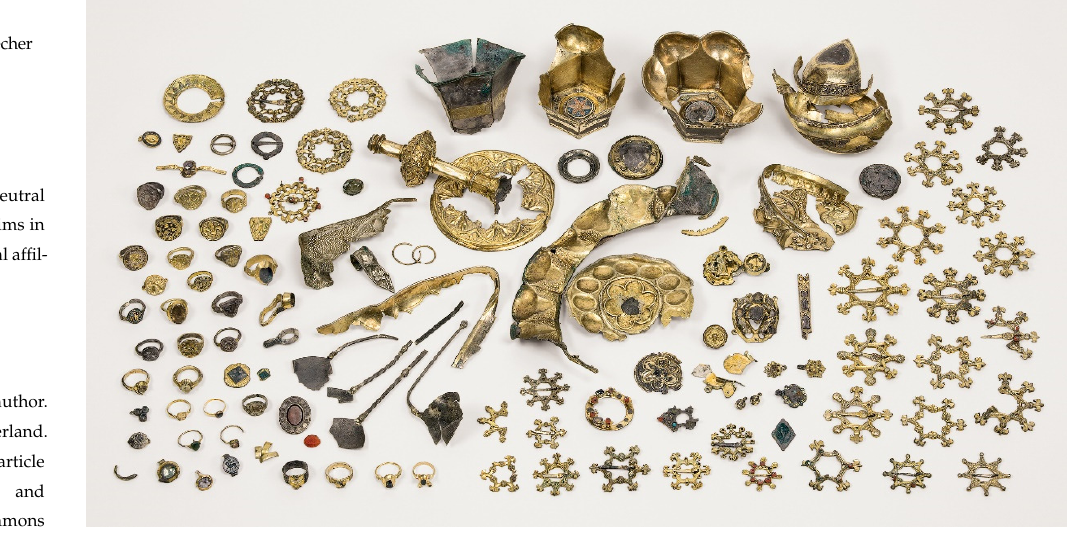
Figure 1. Treasure from Wiener Neustadt. Overall view. Photo: Paul Kolp; editing: Franz Siegmeth.